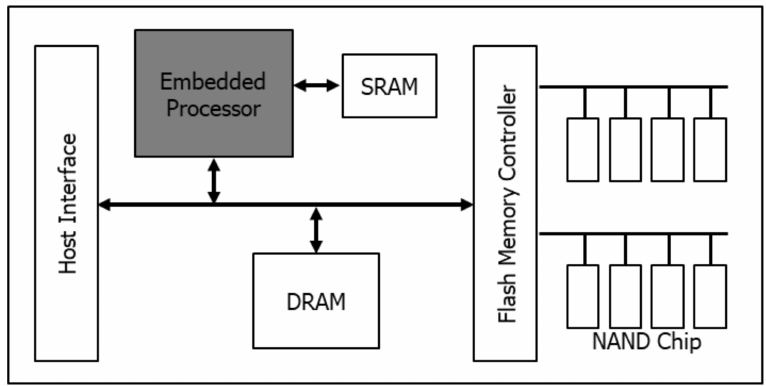
Figure 2. Block diagram of SSD for in-storage